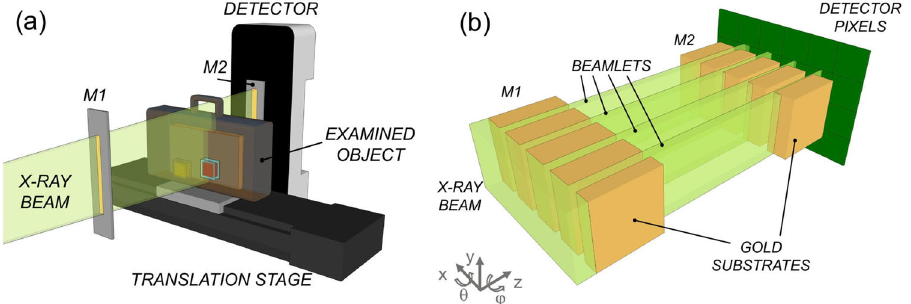
Fig. 1 | Schematic of edge-illumination x-ray imaging. This is shown in panel a , with a zoom-up on the region between the two x-ray masks in panel b (without object). The x-ray beam is split into a plurality of beamlets by a pre-sample mask